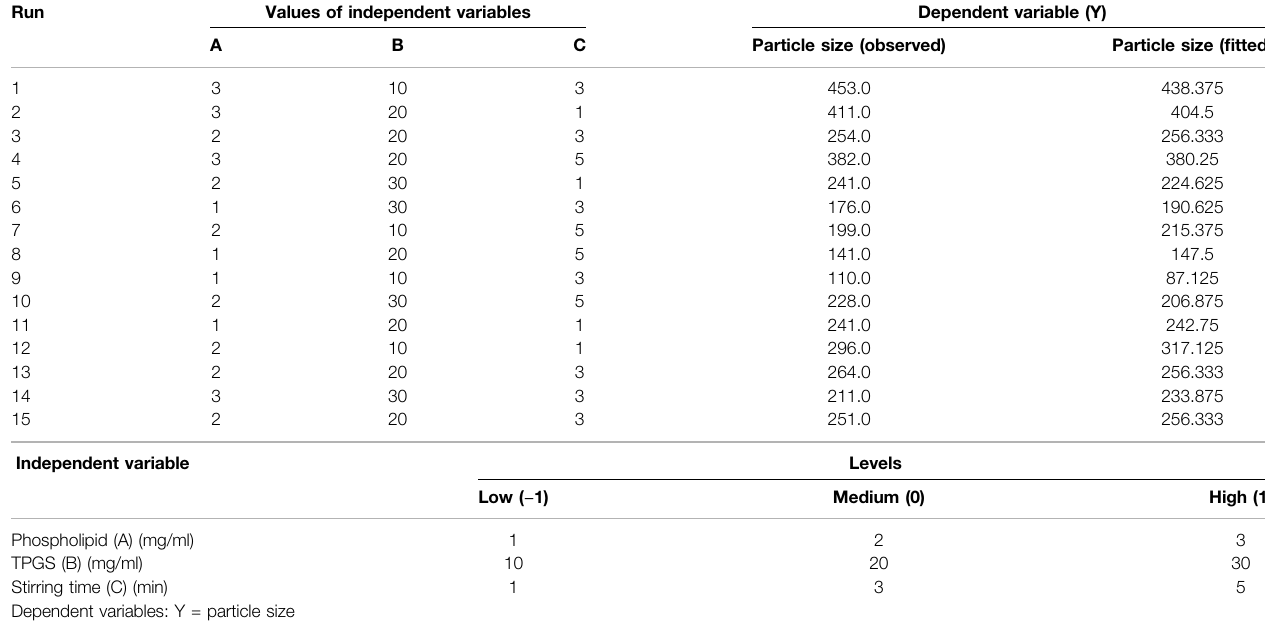
Dependent variables: Y (cid:2) particle